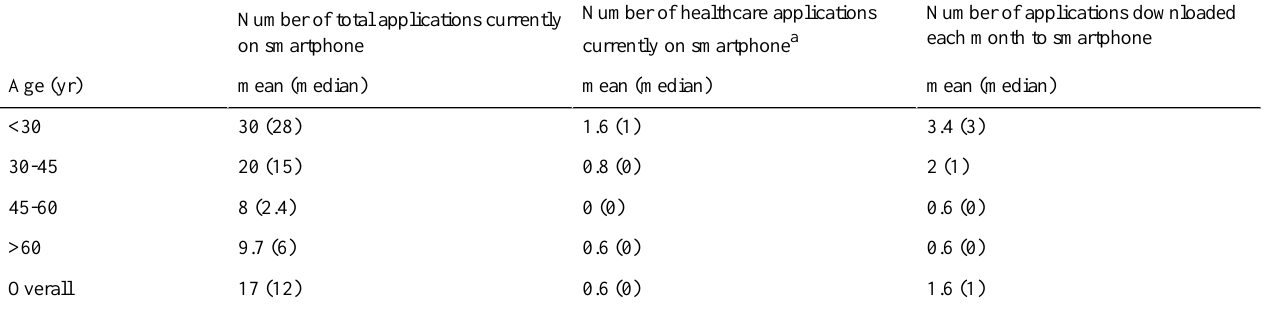
Table 3. Smartphone applications